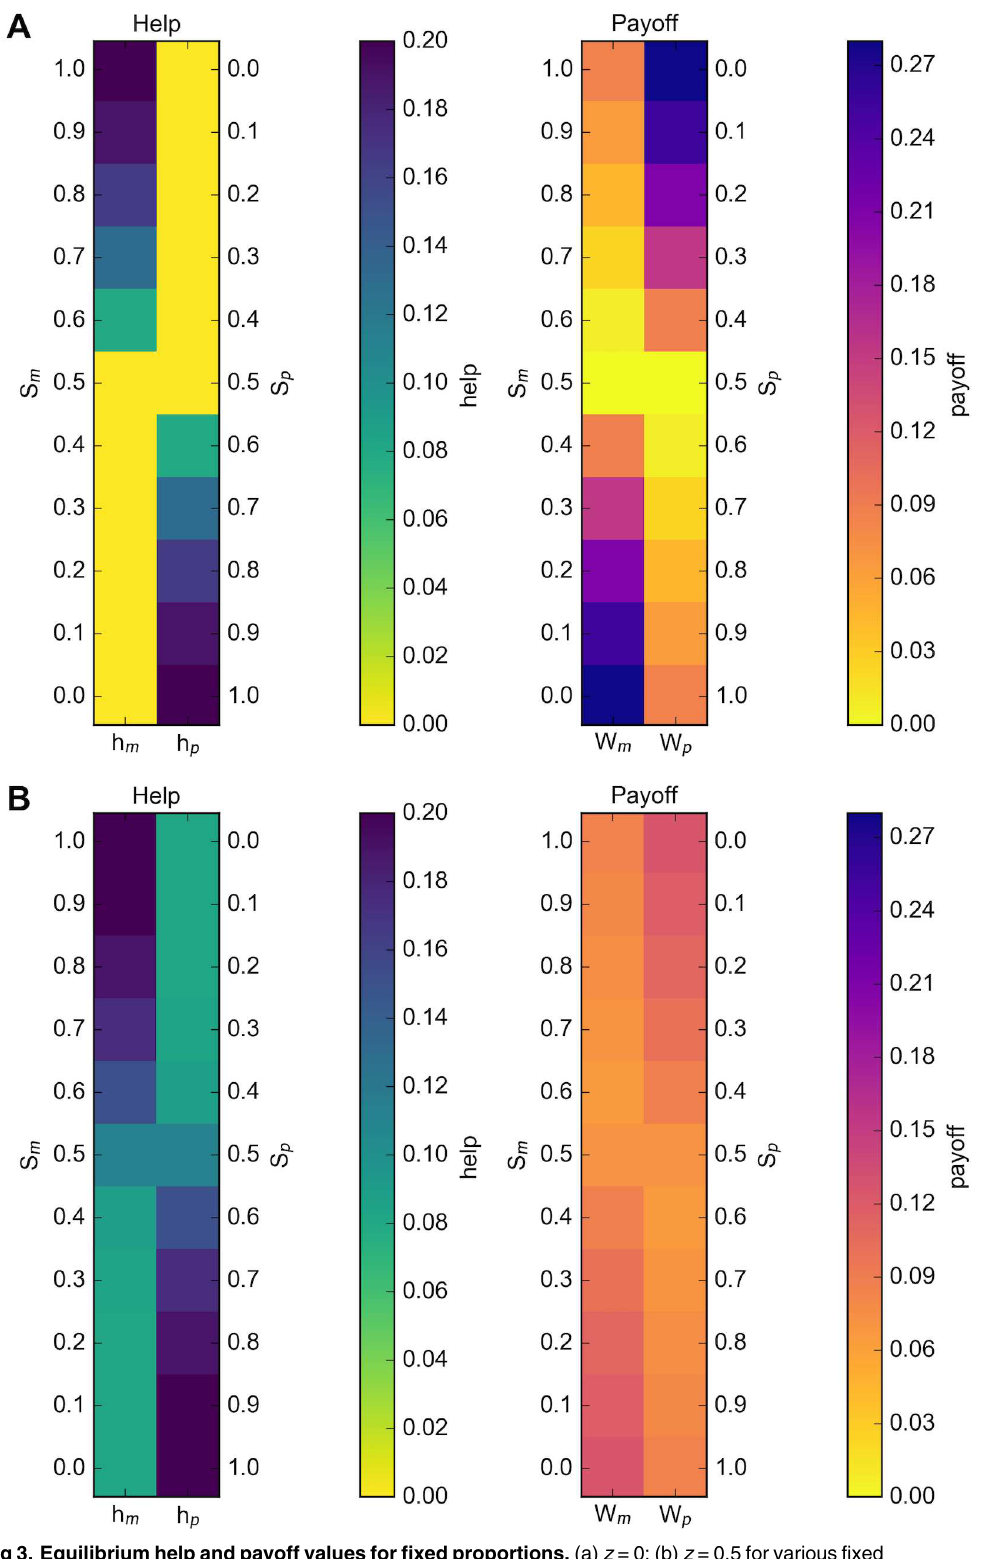
Fig 3. Equilibrium help and payoff values for fixed proportions. (a) z = 0; (b) z = 0.5 for various fixed proportions of S m and S p